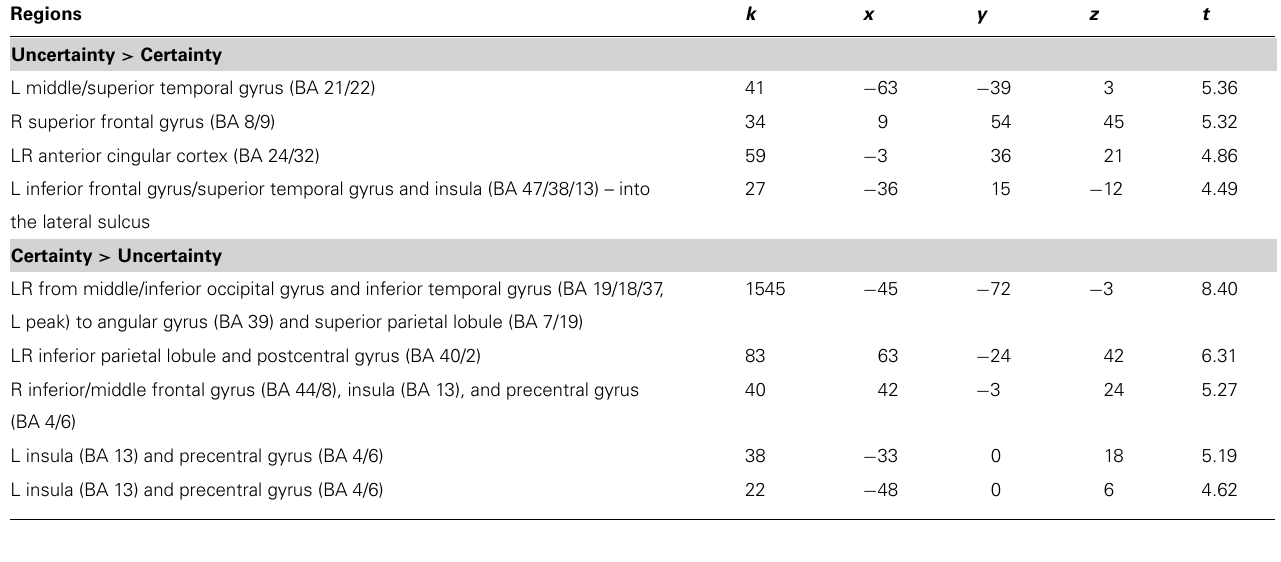
Table 2 | Overview of the neuroimaging results ( p < 0.0005, uncorrected, min. 20 voxels, MNI coordinates in mm, L = left, R = right, LR = left and right). Regions